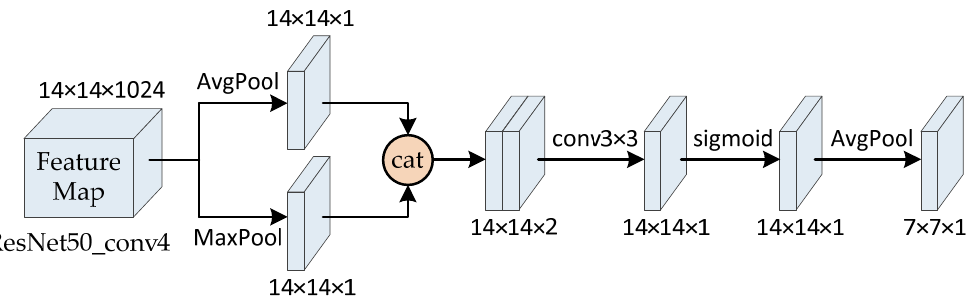
Figure 3. The structure of spatial attention mechanism. cat denotes catenation, conv3 × 3 denotes convolution operation with 3 × 3 kernels.